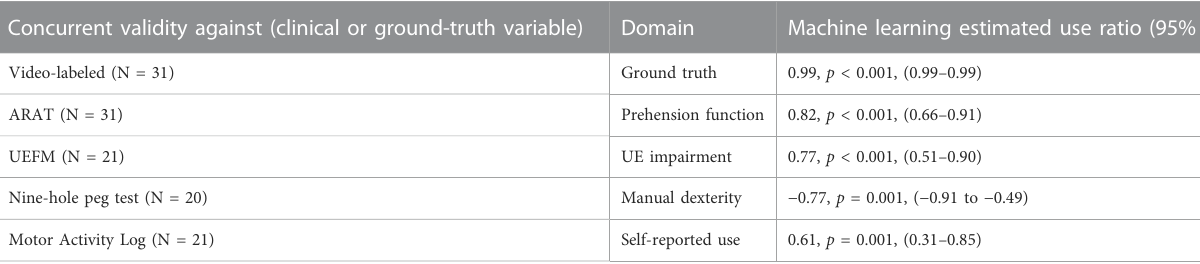
Table2.Pearson ’ scorrelationbetweenuseratiosfromvideo-labeledormachinelearningestimateswithpareticUEActionResearchArmTest(ARAT),pareticsideupperextremityFugl-Meyer (UEFM),andMotorActivityLog(MAL).Thenine-holepegtestcorrelationsarenegativebecausethedataarerecordedinsecondstakentocompletethetask,inverselycorrelatedwithARAT,